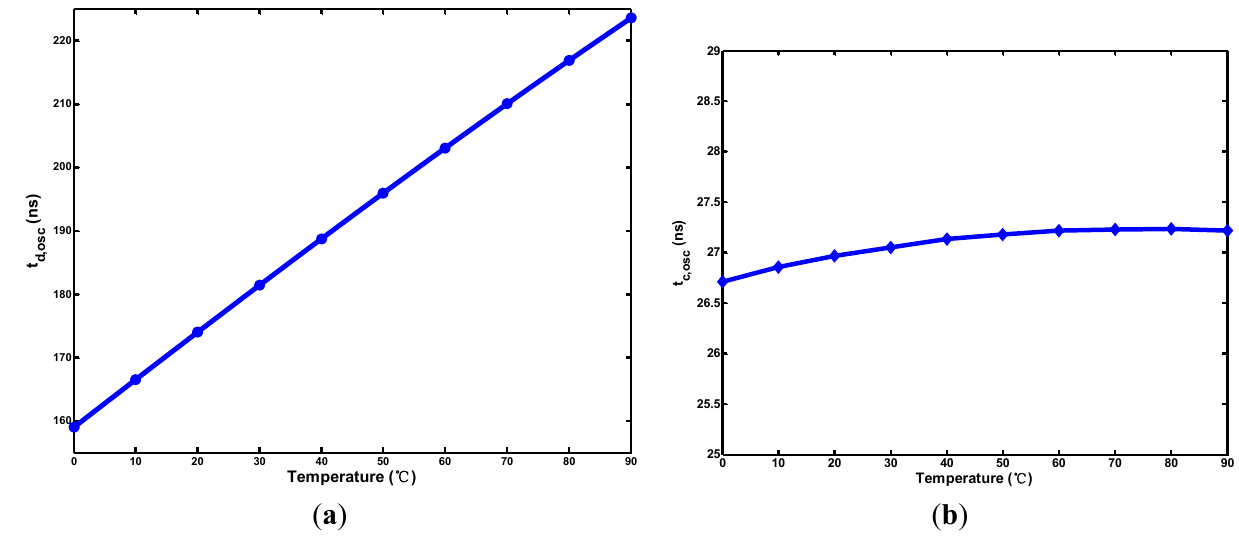
and ( b ) t . d,osc c,osc